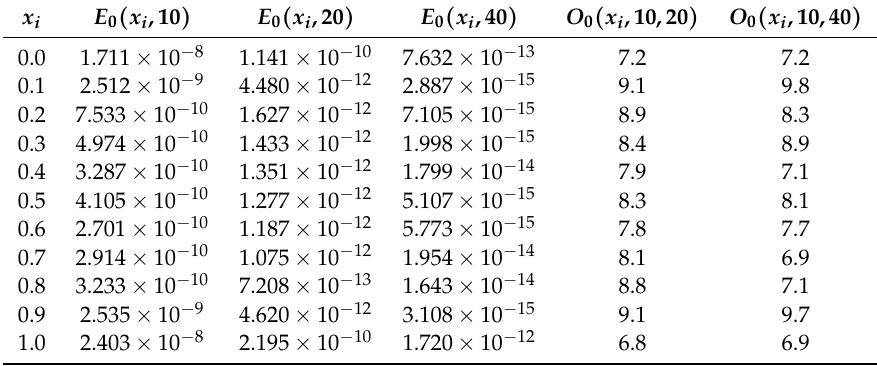
The absolute errors of the function values of y 1 at the knots and the numerical convergence orders.